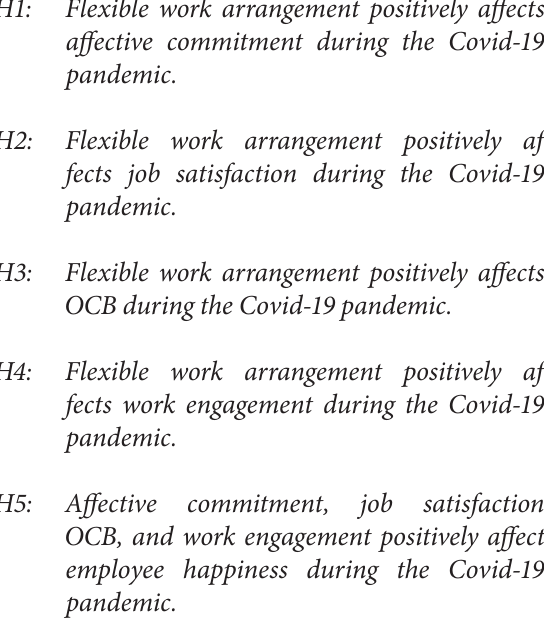
Affective Commitment